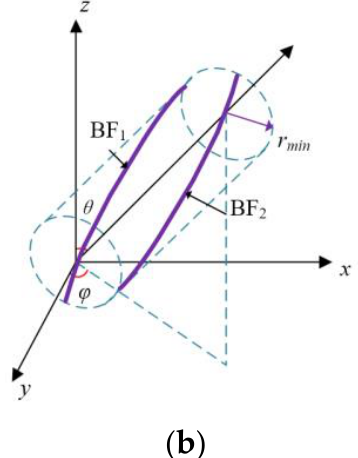
Figure 7. Image division and calibration. ( a ) Joint blocking; ( b ) Spherical coordinate. The orientation and local color information of the visual field could be obtained by using the joint blocking method, and the HSV space was used for color feature extraction, as shown in Figure 7a.